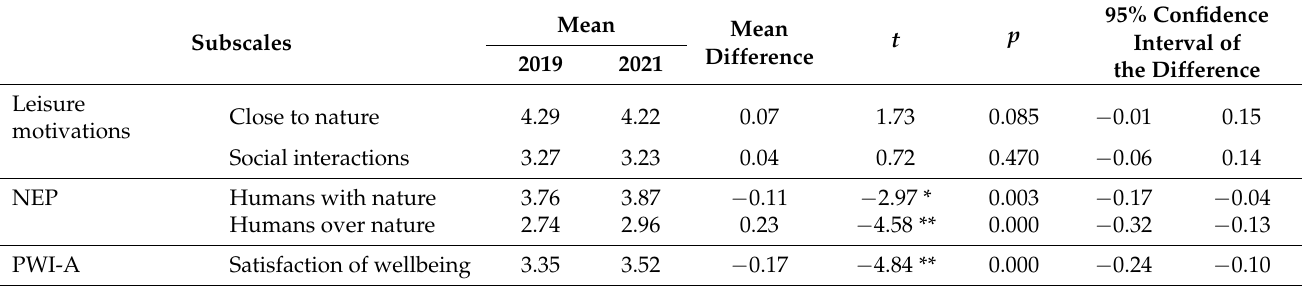
Table 6. T-tests of subscales of the three measures (2019 vs.